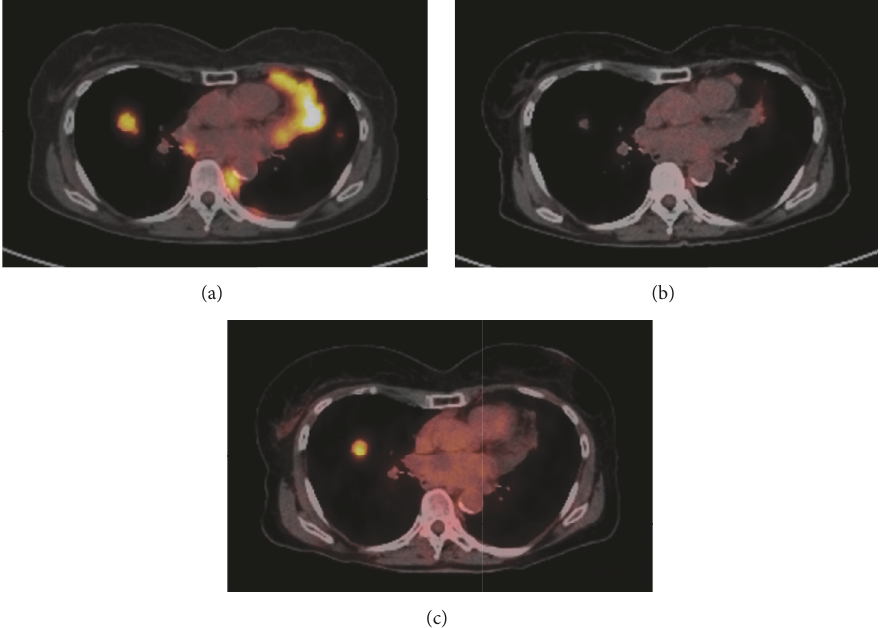
Figure 2: Representative example of a patient with oligoprogressive metastatic breast cancer. (a) PET scan of the central chest at the time of diagnosis of metastatic disease. (b) PET of the same area after 8 months of fulvestrant demonstrating resolution of the FDG avid disease. (c) Surveillance PET scan 6 months later demonstrating solitary site of progressive disease in the right lung. No other evidence of progressive disease was noted in this